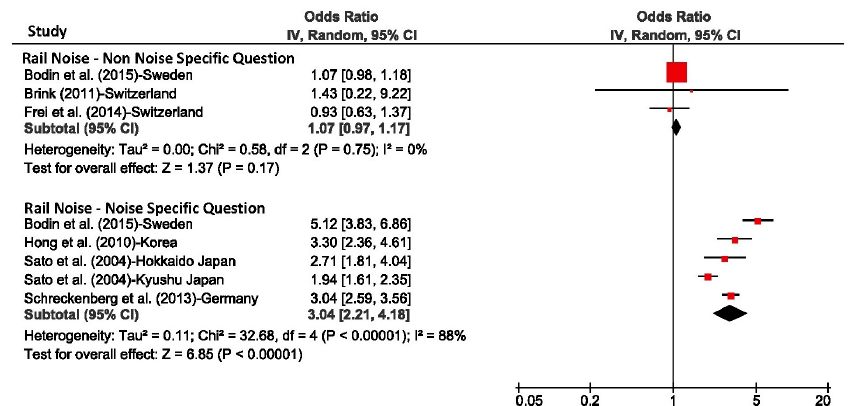
studies and subjects contributing to the analyses can be found in Table 3.